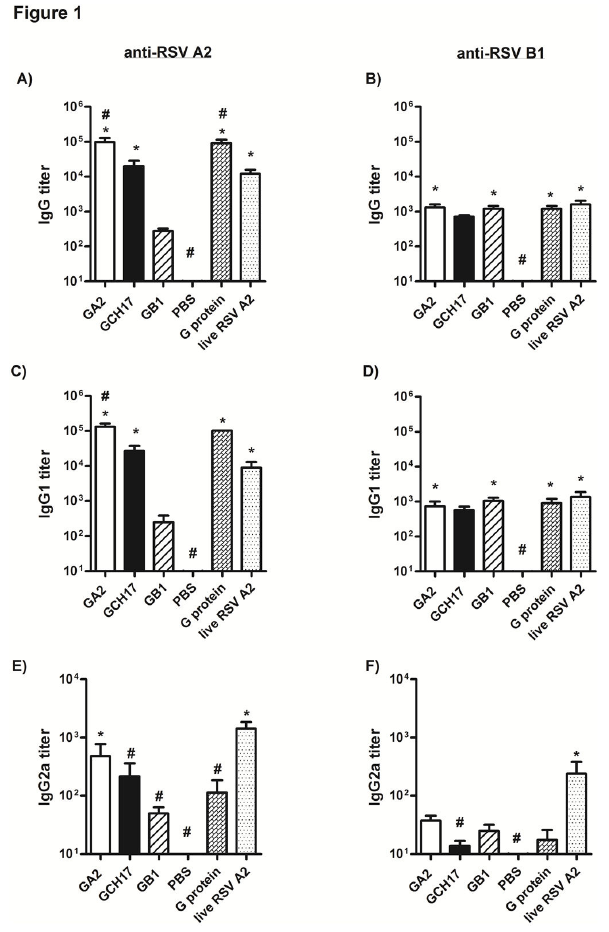
Figure 1. Antibody responses elicited by vaccination with RSV G protein nanoparticles. Groups of BALB/c mice (n=5) were vaccinated with nanoparticle vaccines diluted in PBS to yield 50 µg of designed peptide per dose, with 10 µg of purified G protein emulsified 1:1 with TiterMAX®, 10 5 PFU of live RSV A2 or with 100 µL of PBS. Sera were obtained from blood taken 21 days after the secondary inoculation. RSV A2 (A, C, and E) and RSV B1 (B, D, and F)-specific IgG (A and B), IgG1 (C and D) and IgG2a (E and F) levels were determined by indirect ELISA. Bars represent the average titer of each group with error bars representing the SEM from n=5 mice per group. *, #, p<0.05, significant difference as determined by one-way ANOVA and Dunnett’s test, compared with PBS vaccinated control mice (*) or compared to live RSV A2 vaccinated mice